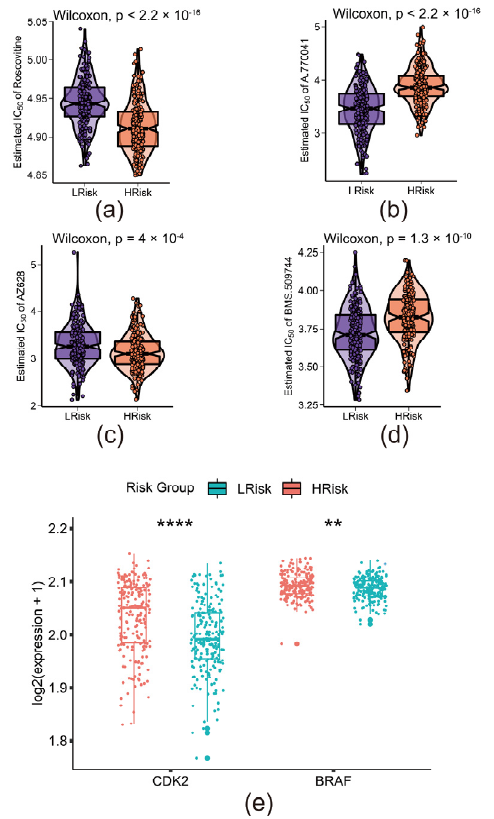
Figure 6. The risk model predicted the sensitivity of novel chemotherapy: ( a – d ) Prediction of chemotherapy sensitivity in high- and low-risk groups based on estimated IC50; LRisk stands for low-risk group; HRisk stands for high-risk group; ( e ) Distributions of targets of two sensitive chemotherapy in the high-risk group; **: p < 0.01; ****: p < 0.0001 .